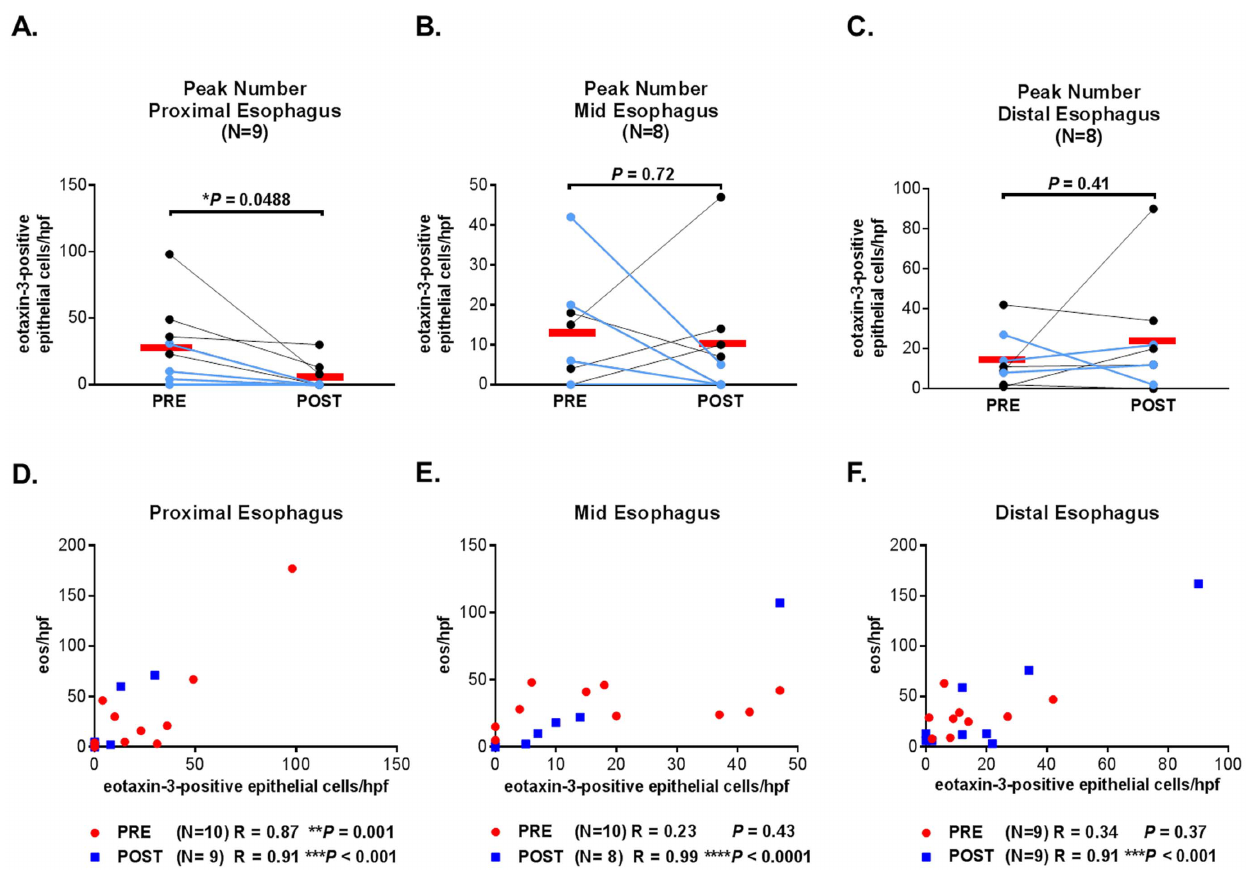
Figure 5. Peak number of eotaxi-3-positive epithelial cells at each esophageal level and correlation with peak eosinophil count. Pre- and post-PPI treatment peak number of eotaxin-3-positive epithelial cells in the (A) proximal, (B) mid, and (C) distal esophagus. Light blue lines represent PPI Responders. Black lines represent PPI Non-responders. Red bars represent means. Correlations between peak eosinophil count and peak number of eotaxin-3-positive epithelial cells are shown pre- and post-PPI treatment in the (D) proximal, (E) mid, and (F) distal esophagus.